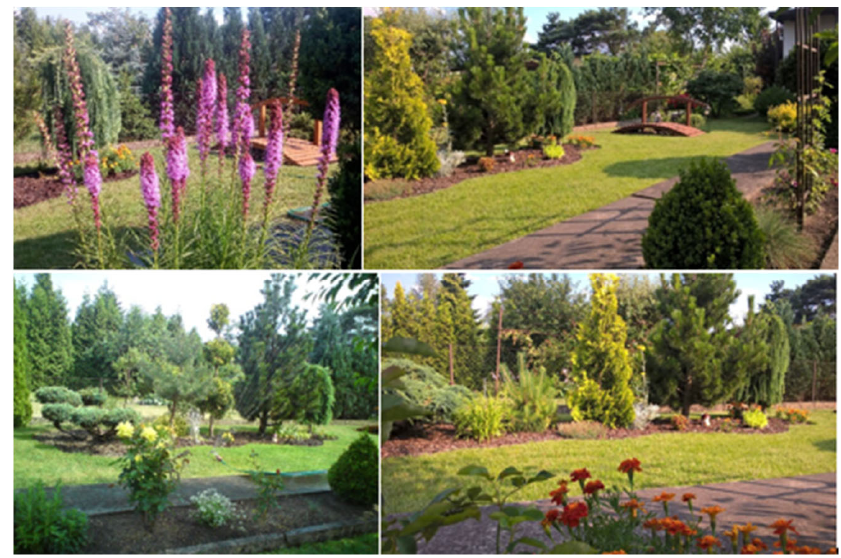
Figure 1. Family allotment garden, Pozna ń (Piotr Rutkowski 2018).